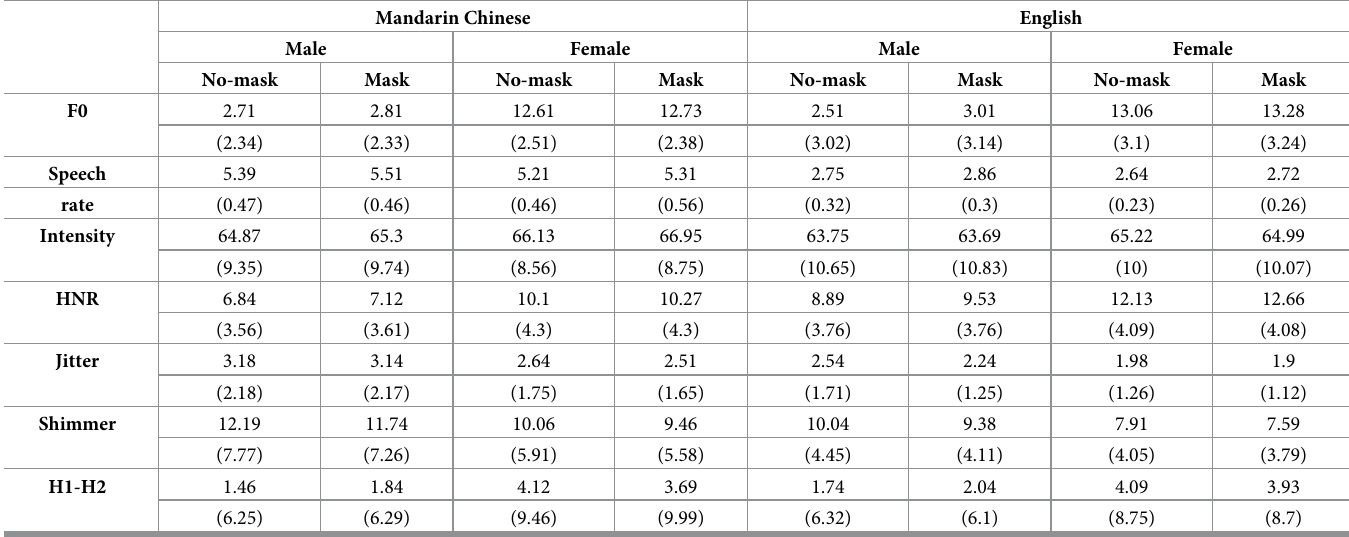
Table 1. Average values (standard deviation) of the seven acoustic parameters with and without mask in Mandarin Chinese and English.